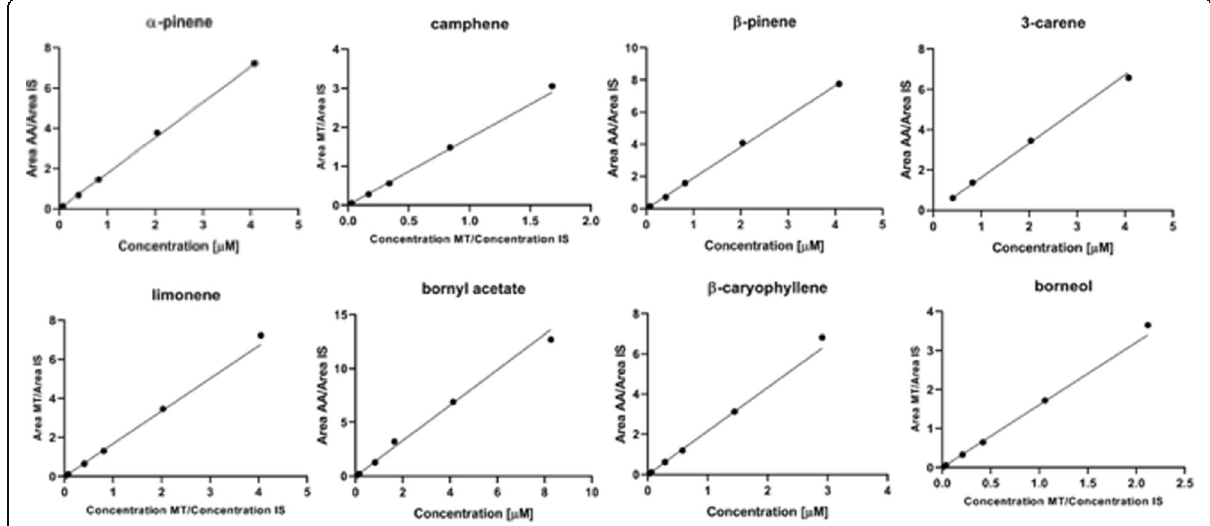
Fig. 2 Calibration curves of the eight